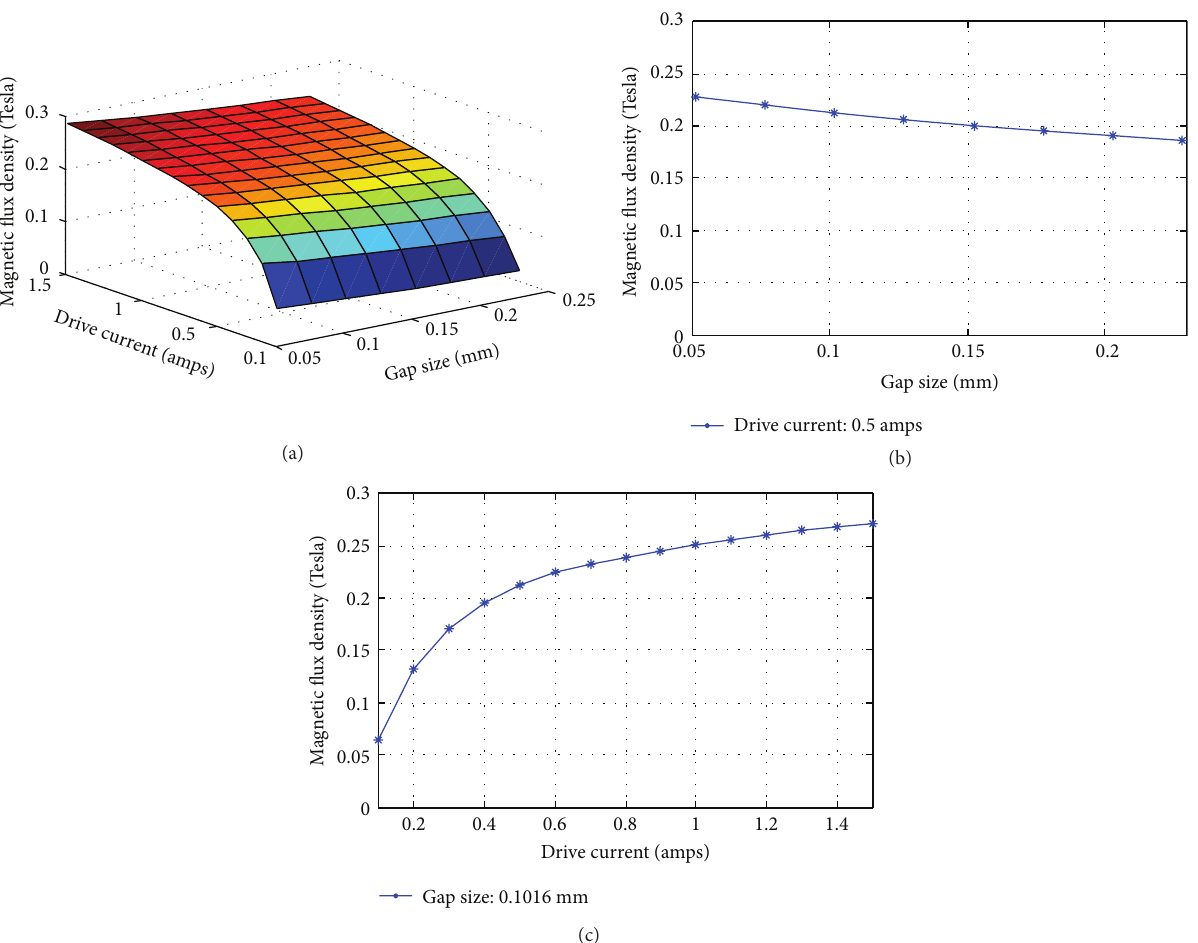
Figure 8: Average magnetic flux density along the effective gap length: (a) various drive currents (from 0.1 amps to 1.5amps) and various gap sizes (from 0.05 mm to 0.23 mm), (b) various gap sizes with drive current 0.5 amps, and (c) various drive currents with gap size 0.1016mm (0.004 in).